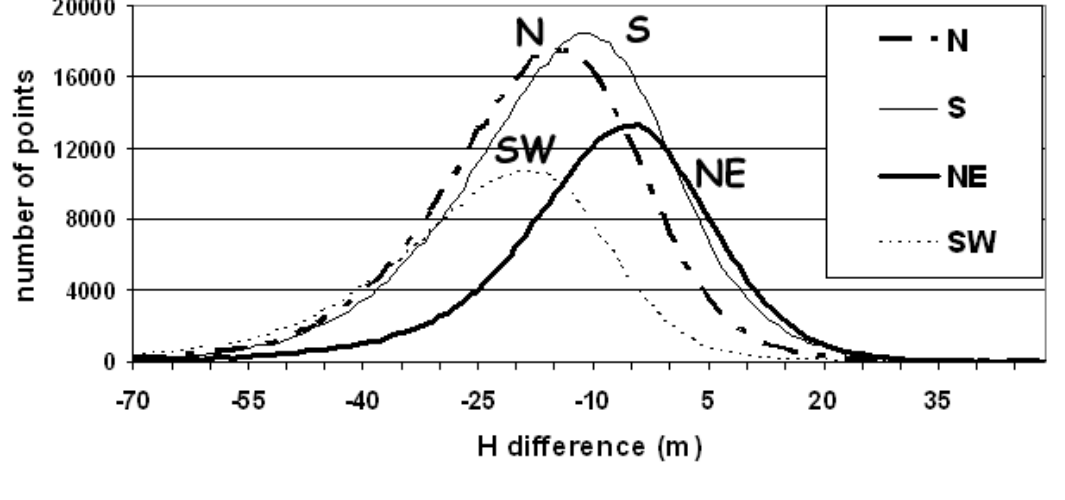
Figure 6. The frequency distributions per geographic direction. The y-axis represents the umber of grid points per 1 m elevation difference